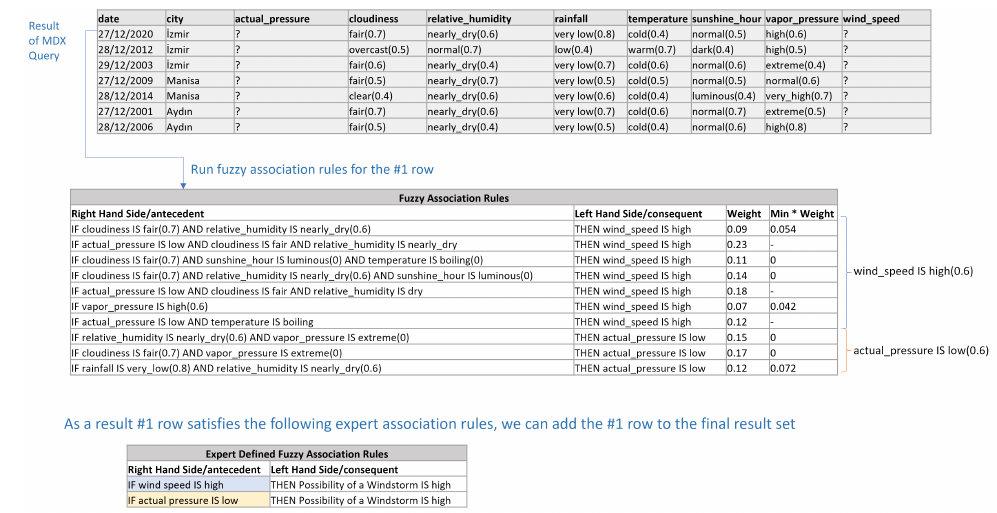
Figure 19. Fuzzy spatiotemporal predictive query execution: step 2.